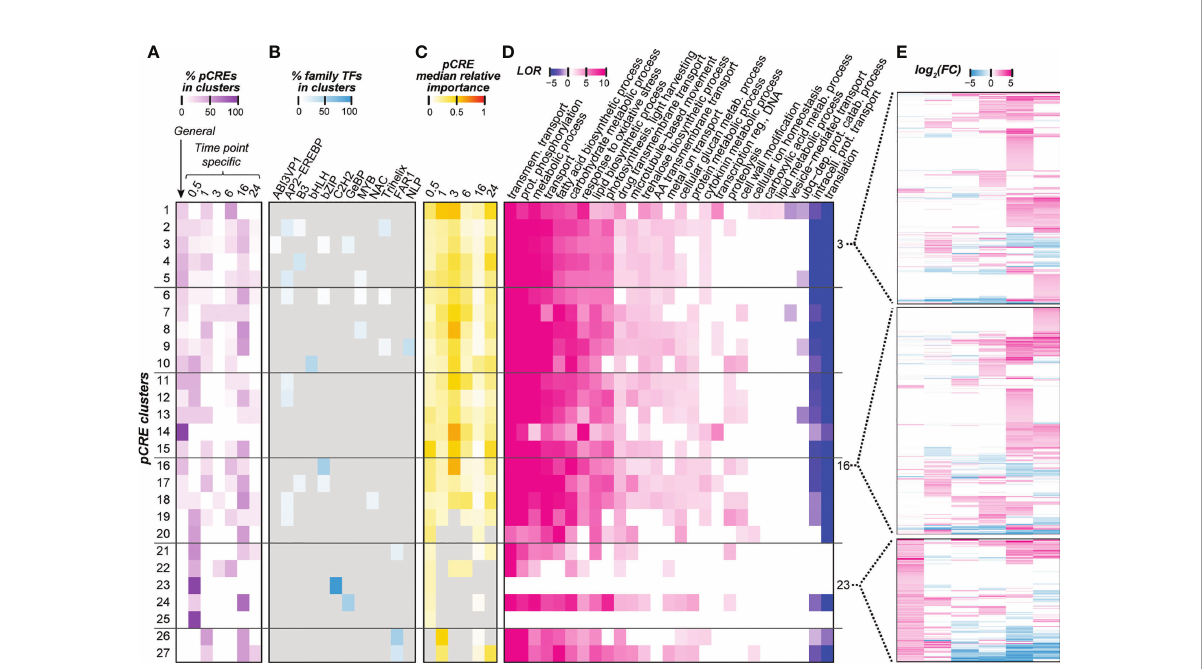
FIGURE 4 Properties of pCRE clusters which were de fi ned based on sequence similarity. (A) Heatmap showing the distribution of general and time point- speci fi c pCREs within a cluster. Color scale represents the percentage of general and time point-speci fi c pCREs in each pCRE cluster. (B) Potential transcription factors (TFs) that could bind to pCREs in pCRE clusters based on the similarity between pCREs and TF binding sites (TFBS) information based on in-vitro binding assays. A TF was considered to bind a pCRE only if the PCC similarity between the pCRE and its binding sites was above the 95 th percentile of the background PCC distribution, which was calculated among TFs in the same TF family. TF families that don ’ t fall under this threshold were marked in gray. Color scale represents the percentage of pCREs within a pCRE cluster that showed signi fi cant similarity with TFBS. (C) Median importance of pCREs in a cluster. Cell color depicts median min-max scaled Gini index of the pCREs within each cluster. Gray color indicates that the pCRE is not used in the time point model in question. (D) Signi fi cantly enriched biological GO terms of genes containing pCREs in a pCRE cluster. Color scale represents the log 10 (odds ratio), for details, see Methods. (E) Differential expression of genes that contain pCREs in clusters 3, 16, or 23 at different time points. Each row shows the pro fi le of a gene, and color scale indicates log 2